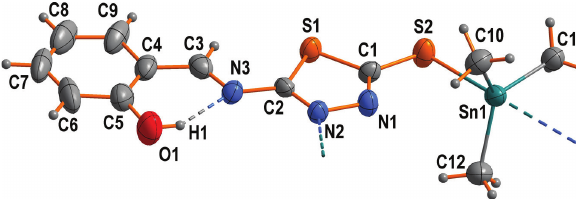
Table 1: Data collection and handling.